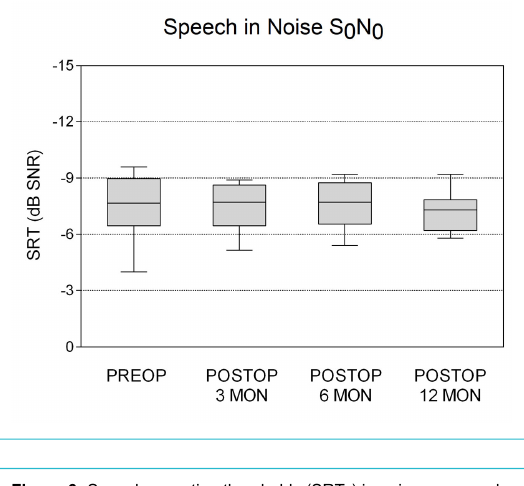
Figure 6: Speech reception thresholds (SRTs) in noise measured in the sound field preoperatively and 12 months after CI activation. See figure 1 for a description of the tested spatial configurations. * p <0.05; ** p